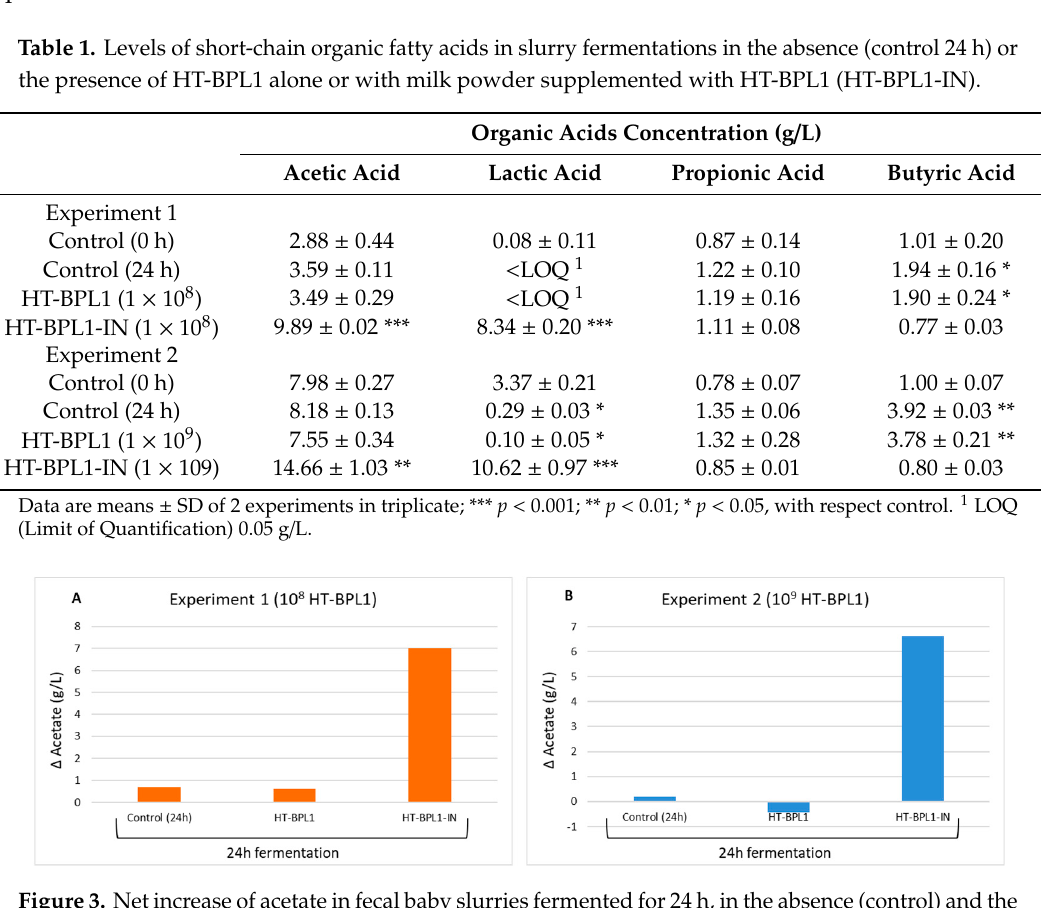
Figure 3. Net increase of acetate in fecal baby slurries fermented for 24 h, in the absence (control) and the presence of HT-BPL1 alone or HT-BPL1 included in an infant milk formula (Innova) supplemented with HT-BPL1 cells (HT-BPL1-IN). ( A ) experiment 1 done with a baby slurry in the presence of 10 8 HT-BPL1 cells; ( B ), experiment done with a baby slurry in the presence of 10 9 HT-BPL1 cells. Data calculated from Table 1, by subtracting the background level of acetate in a non-fermented slurry (0 h in the table).